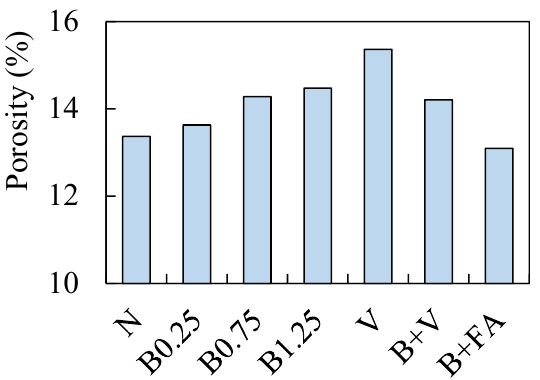
Figure 2. Porosity of mortar measured in laboratory test.